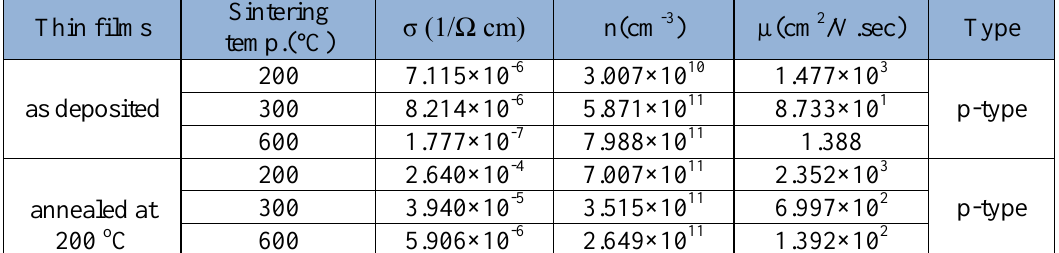
Cu O film deposited at room temperature and 2 2 4